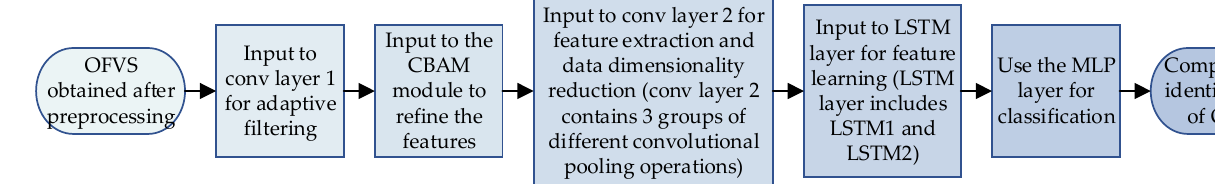
Figure 7. CNN-CBAM-LSTM network flow chart.